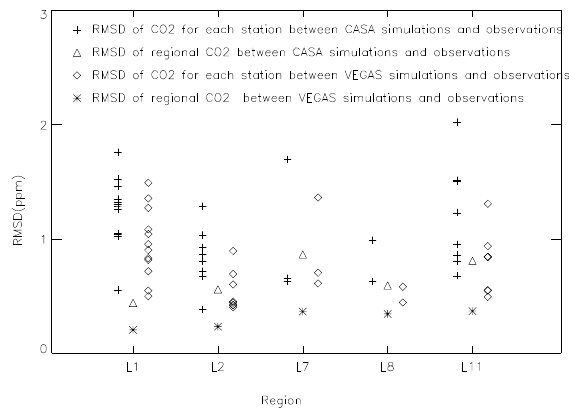
Fig. 8. Comparisons of RMSD at each station and regionally av- Fig. 8 Comparisons of RMSD at each station and regionally averaged values between model eraged values between model results and observations for 5 land results and observations for 5 Land regions (L1: Boreal North America, L2: Temperate regions (L1: boreal North America, L2: temperate North America, North America, L7: Eurasian boreal, L8: Eurasian Temperate, L11: Europe) in 2006. L7: Eurasian boreal, L8: Eurasian temperate, L11: Europe) in 2006. Each region is shown in Fig. 4. Triangle (Asterisk) denotes RMSD of regionally averaged values Each region is shown in Fig. 4. Triangle (asterisk) denotes RMSD of regionally averaged values between model results using fluxes from 23 CASA (VEGAS) and observations; cross (diamond) denotes RMSD of each station between model results using fluxes from CASA (VE- GAS) and